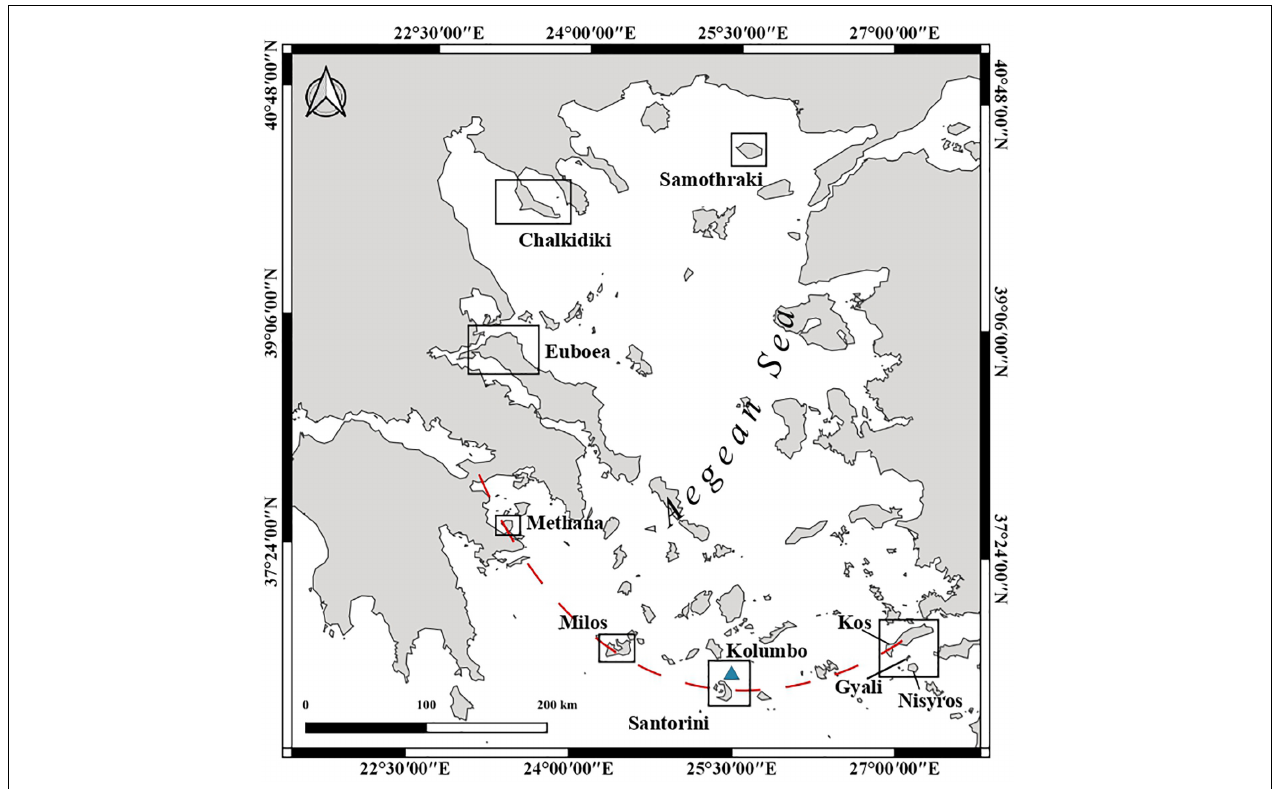
FIGURE 1 | Map of the Aegean sea where the south Aegean active volcanic arc (SAAVA) is drawn with a dashed red line. Study areas are delimited in black squares, while Kolumbo is marked with a light blue triangle. Details on the study areas are found in section “Geological and Geochemical Description of the Submarine Degassing Areas and in situ